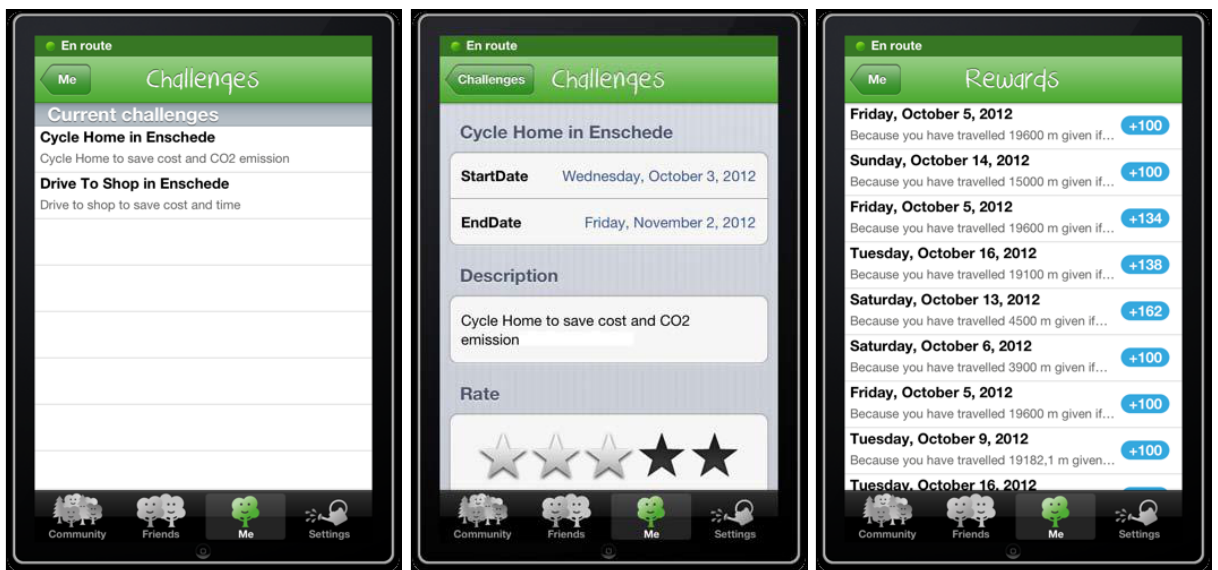
Figure 7. Challenges and